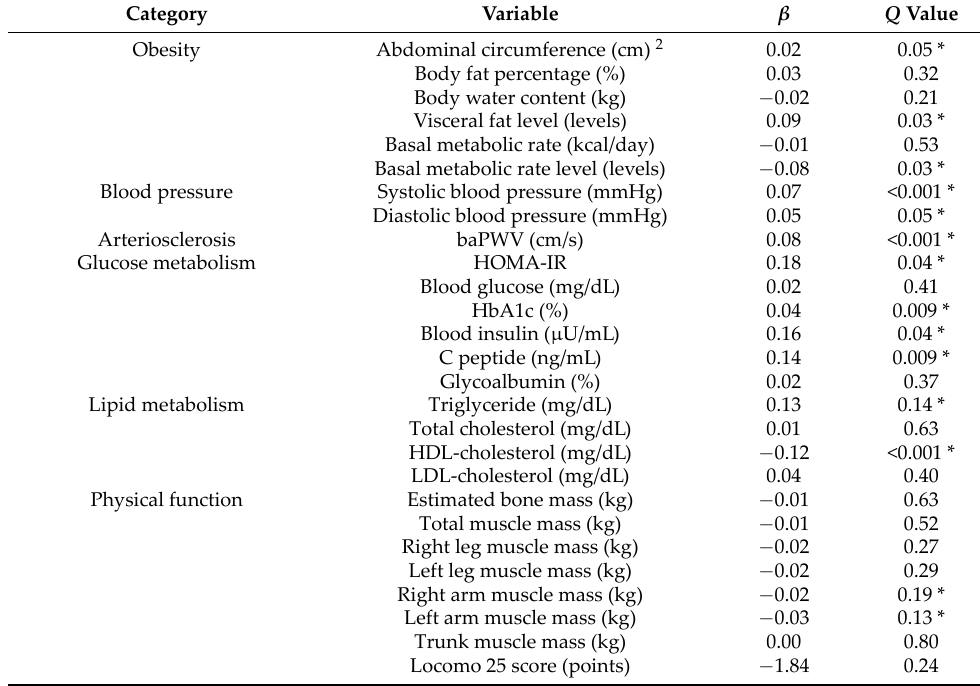
Table 3. Association between plasma LBP concentration and clinical markers or clinical scores 1 (Only categories that were significantly associated with plasma LBP concentrations are